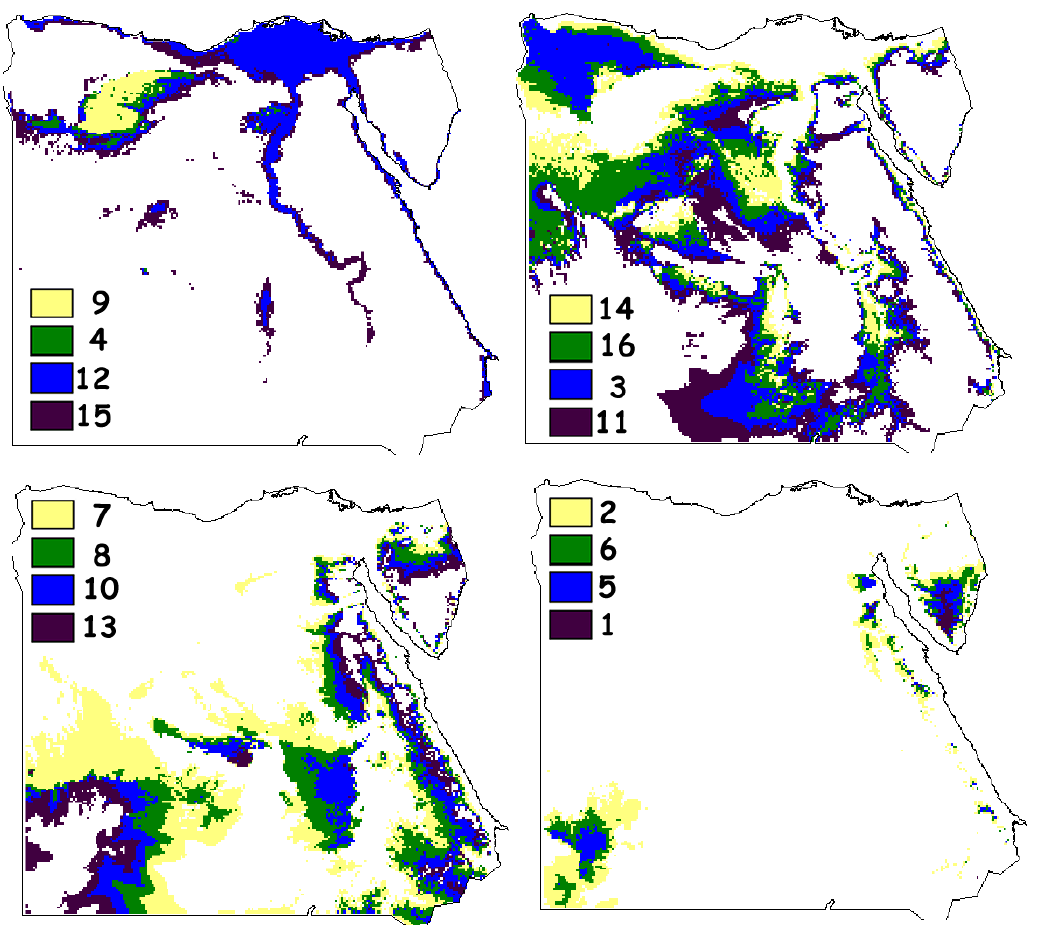
Figure 10. The spatial distribution of the 16 clusters corresponding to the elevation biased clustering. The clusters were organized in four groups in increasing mean elevation according to Figure 8. Both seasonal LST variations and the spatial distributions of regions with the same elevation range are revealed. Thus the most elevated clusters (2, 6, 5, 1) map the spatial extent of two regions with different annual LST variability in Sinai (NE) while in the lowland (clusters 9,4,12,15) LST differences are identified among regions in Nile Delta, Nile River, Alexandria Lake and the coastal zone in the north (Mediterranean Sea) and east (Red